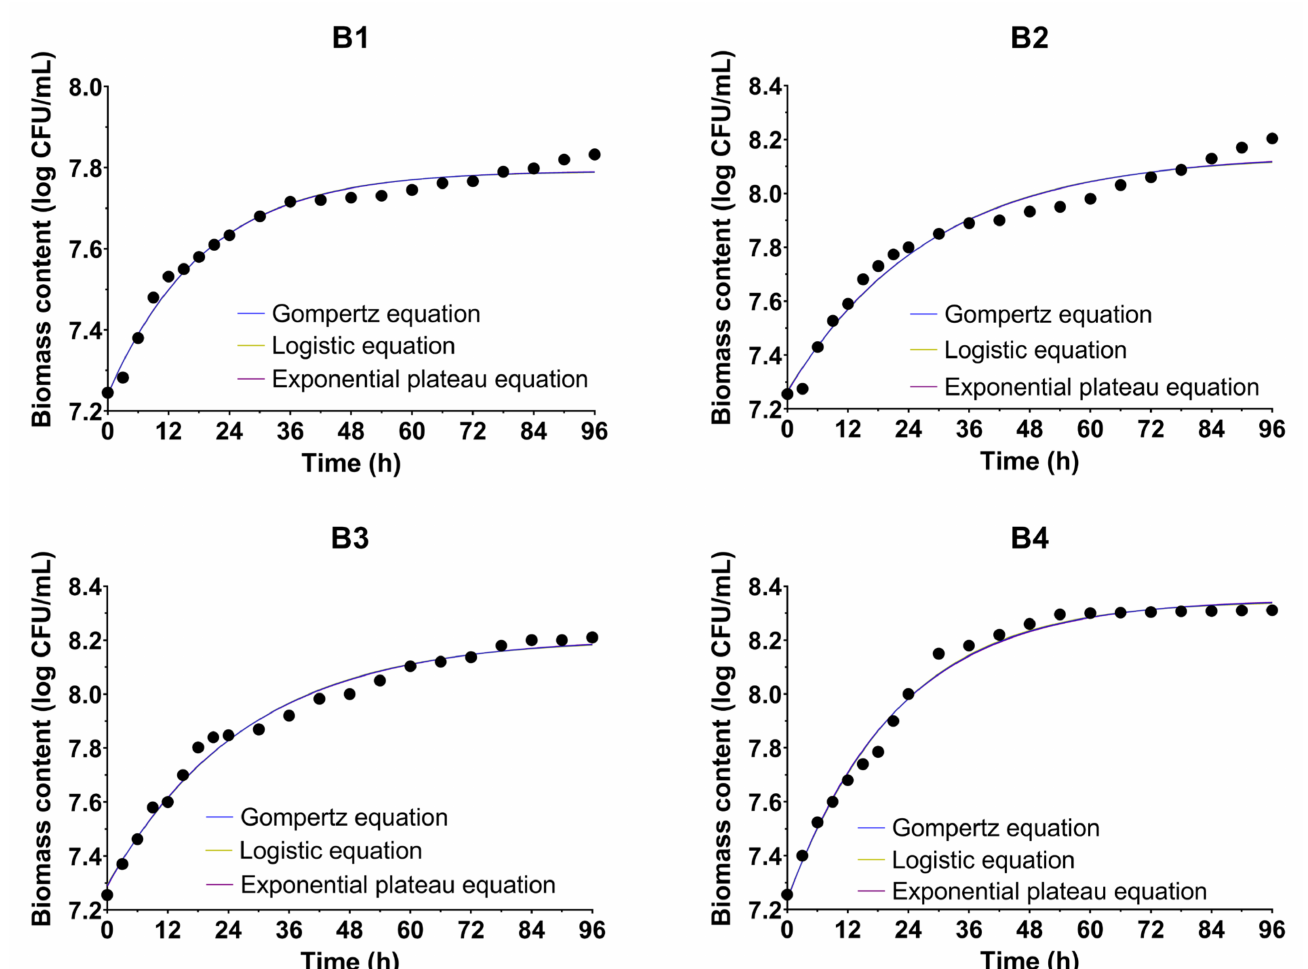
Figure 2. Growth curves of Bacillus sp. BioSol021 under different cultivation conditions fitted using the Gompertz, logistic, and exponential plateau equations. B1: 0.5 vvm, 100 rpm; B2: 0.5 vvm, 300 rpm; B3: 1.5 vvm, 100 rpm; B4: 1.5 vvm, 300